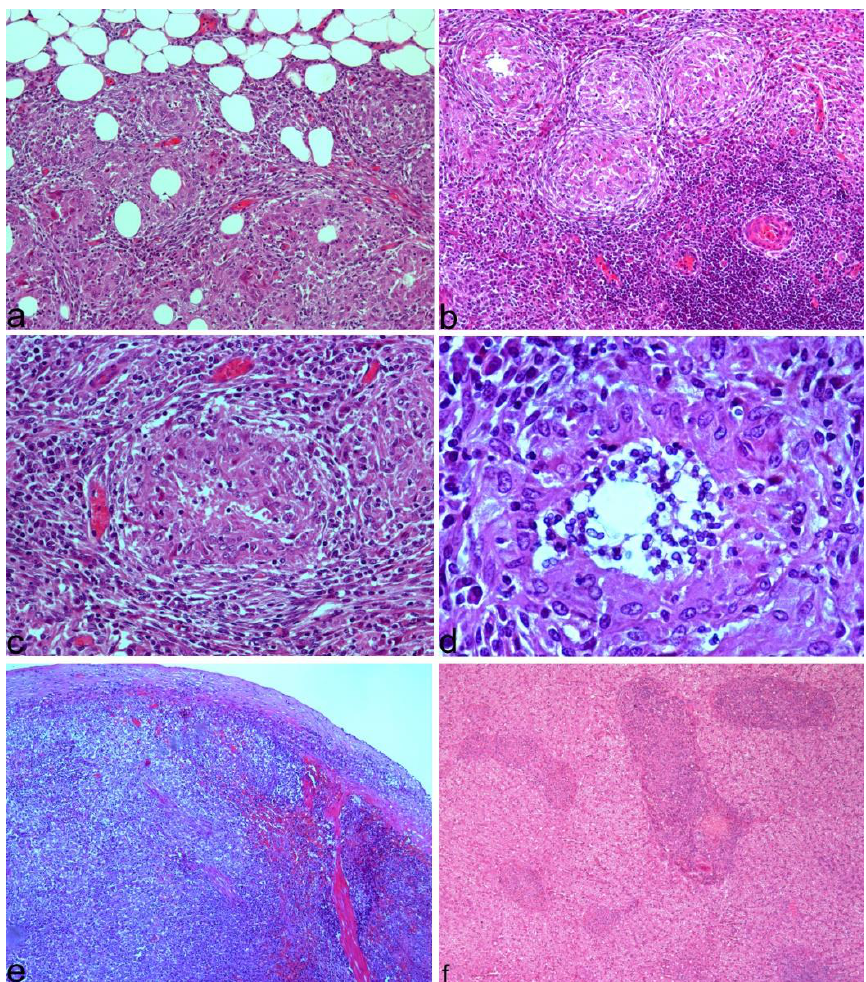
Figure 2. Microscopic findings in dog 1. ( a ) Intense granulomatous peritonitis infiltrating the peritoneal fat, with numerous granulomas and variable number of lymphocytes. H&E; 100 × . ( b ) Several granulomas mainly composed of macrophages. Large number of lymphocytes are seen in the lower right area. H&E; 100 × . ( c ) Granuloma composed of macrophages and few lymphocytes. H&E; 200 × . ( d ) Piogranuloma with neutrophils in the center. H&E; 400 × . ( e ) Marked granulomatous splenitis. H&E; 50 × . ( f ) Granulomatous hepatitis with multifocal variable-sized granulomas. H&E; 50 × .